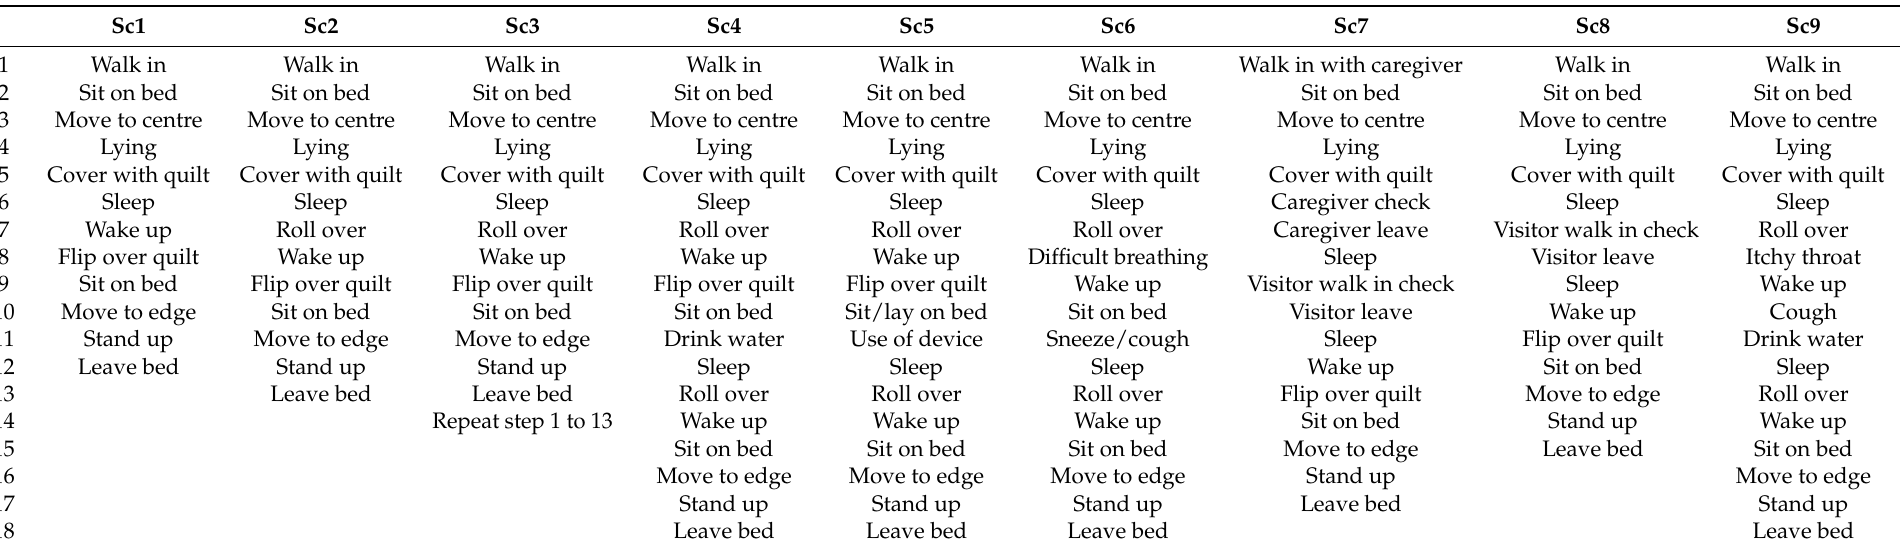
Table 3. Nine different scenarios in the experiment. Row number denotes the step in each scenario to be followed.